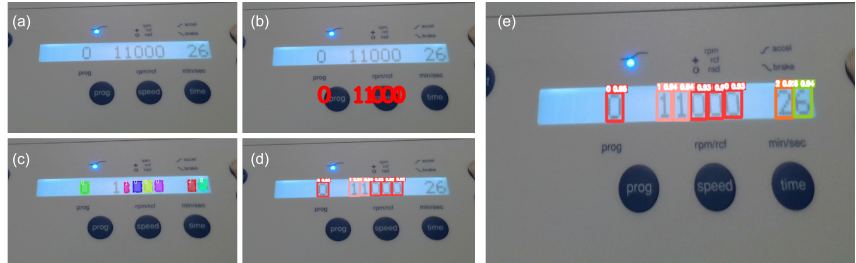
Figure 6. An example of the detection results. ( a ) Original Image. ( b ) Template Matching result. ( c ) Mask R-CNN result. ( d ) Pure YOLOv5 result. ( e ) FLIMM result. The detection results of ( b ) are, from left to right: 0,1,1,0,0,0 1, where the last two digits are missed and a 0 is mistakenly